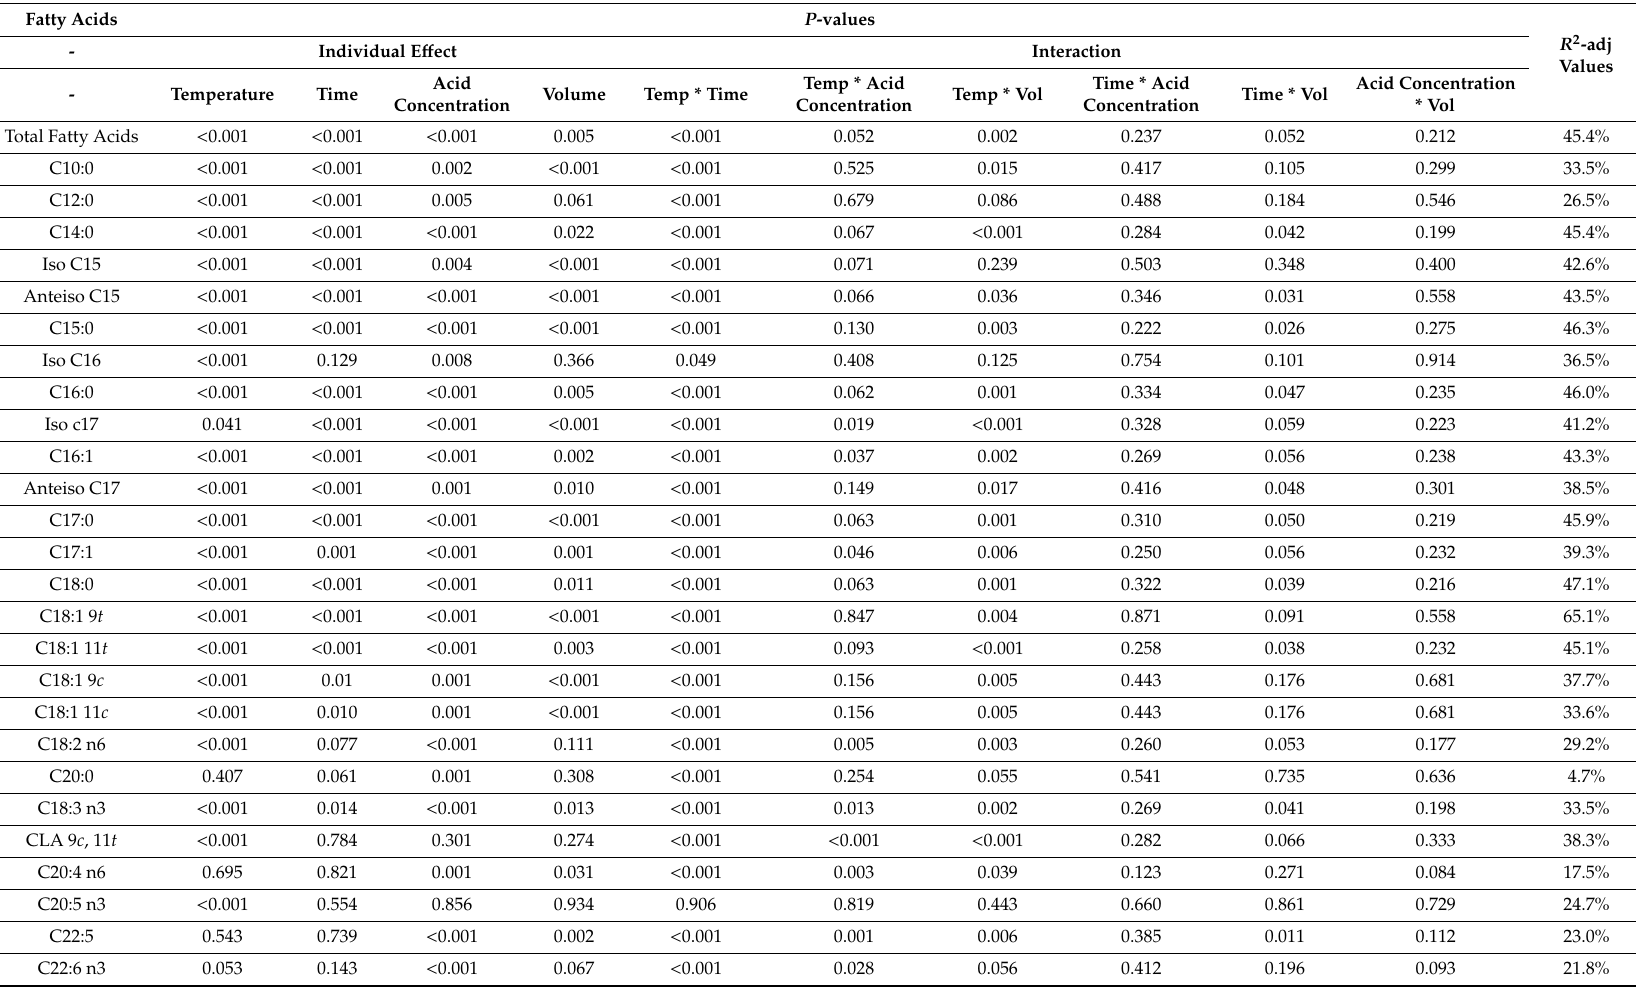
Table 1. Summary of FA (fatty acid) yield responses using surface analyses of the di ff erent conditions